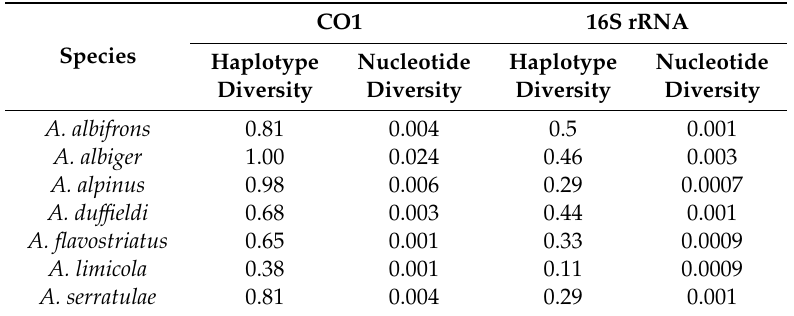
Table 4. Mitochondrial cytochrome oxidase 1 and 16S rRNA per cent haplotype and nucleotide diversity as identified by the network and phylogenetic analyses within Anoscopus .